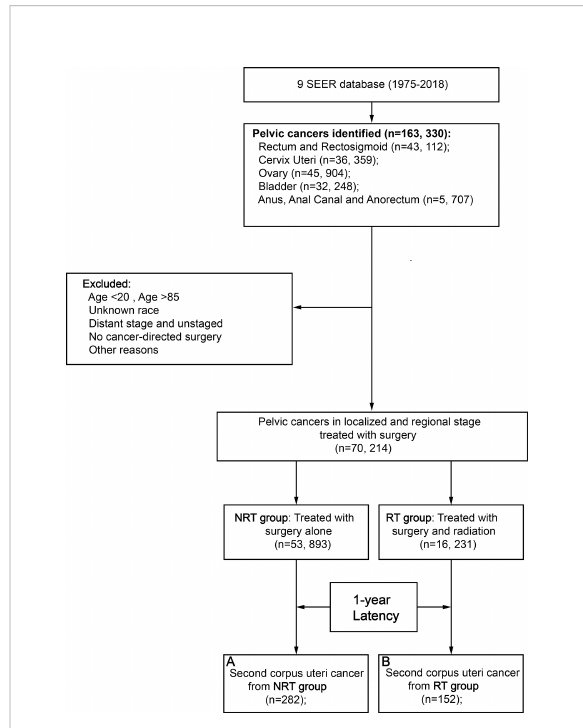
FIGURE 1 Flow diagram. RT, radiation therapy; NRT, no radiation therapy; SEER, Surveillance, Epidemiology and End Results; PSM, propensity score